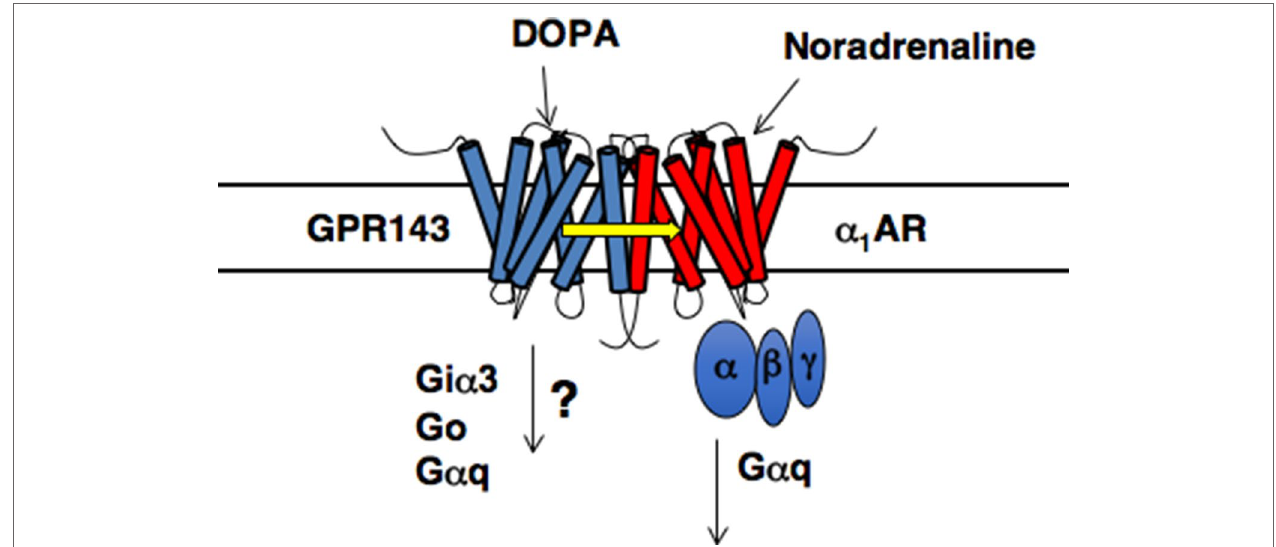
FIGURE 1 | Proposed model of GPR143 and α 1 B AR heteromers (modified from Maurice et al.,